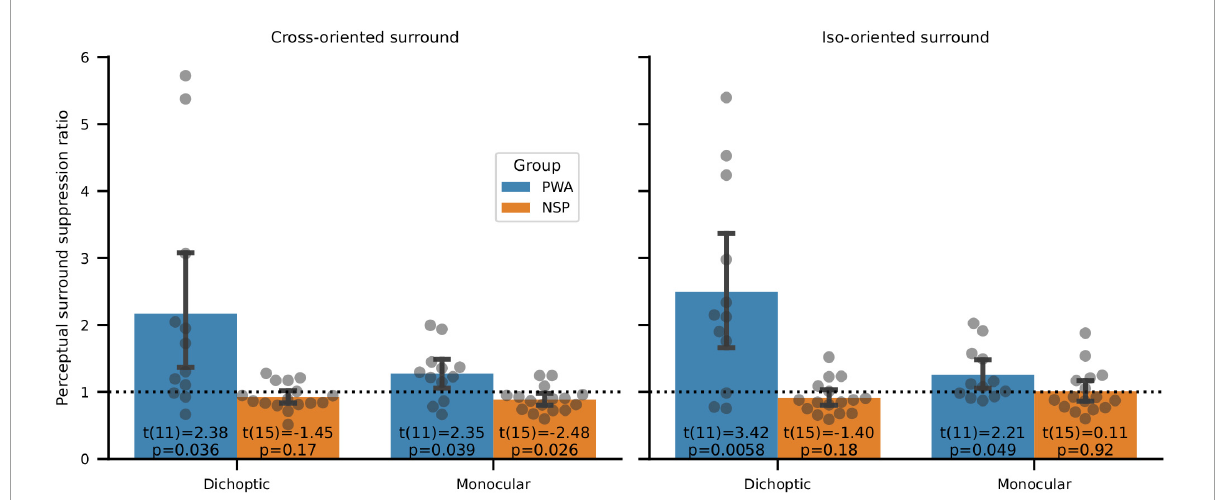
FIGURE9 Perceptual surround suppression. Data points are NDE:DE suppression ratios for individual subjects. Bars indicate means and standard errors. In PWA, one-sample t -tests of whether suppression ratios were different from a value of 1 showed significantly more suppression of the DE than the NDE in all four conditions (cross- and iso-oriented surrounds and dichoptic and monocular conditions). Suppression ratios were not significantly different from a value of 1 for NSP in 3 out of 4 conditions, and the fourth condition (cross-oriented surround, monocular presentation) showed a significant difference in the opposite direction from PWA (i.e., more suppression in the NDE than the